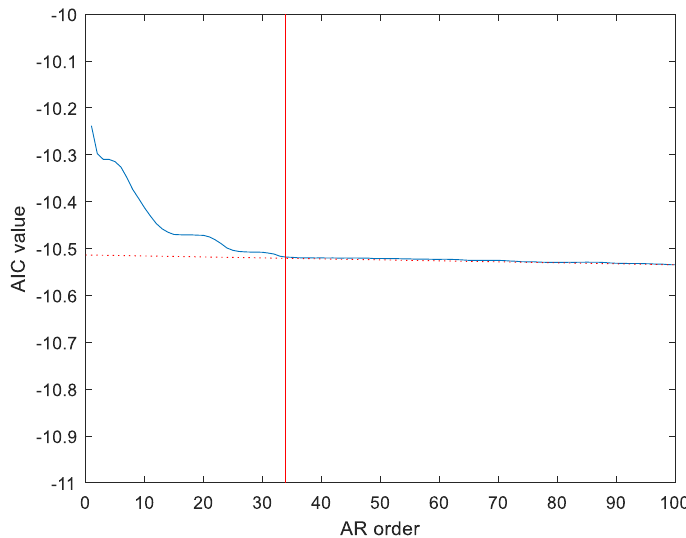
Figure 3. AIC value of the HIFU echo signal.